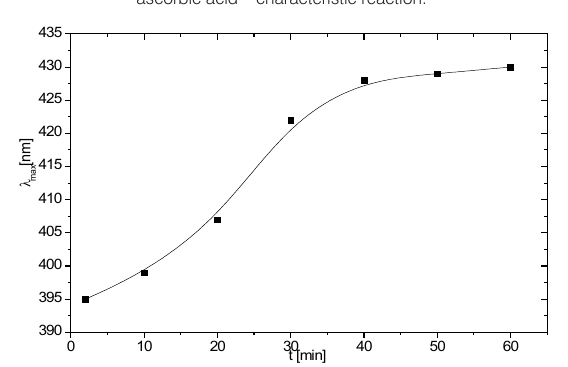
Figure 8. Position of an absorption band maximum of the Ag NPs obtained in different duration of the characteristic